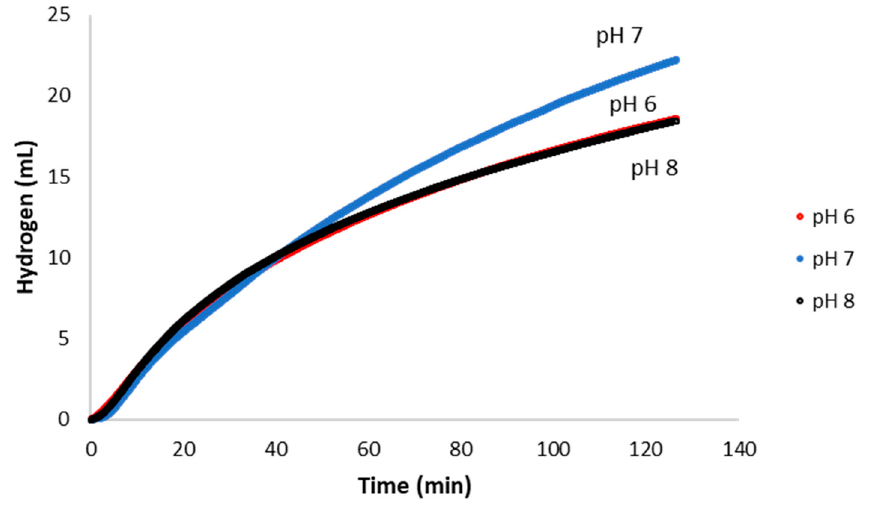
Figure 7. Comparison of the volume of hydrogen gas generated versus time. Volume of hydrogen gas generated by silver nanoparticle networks under adjusted pH conditions (pH 6–8).